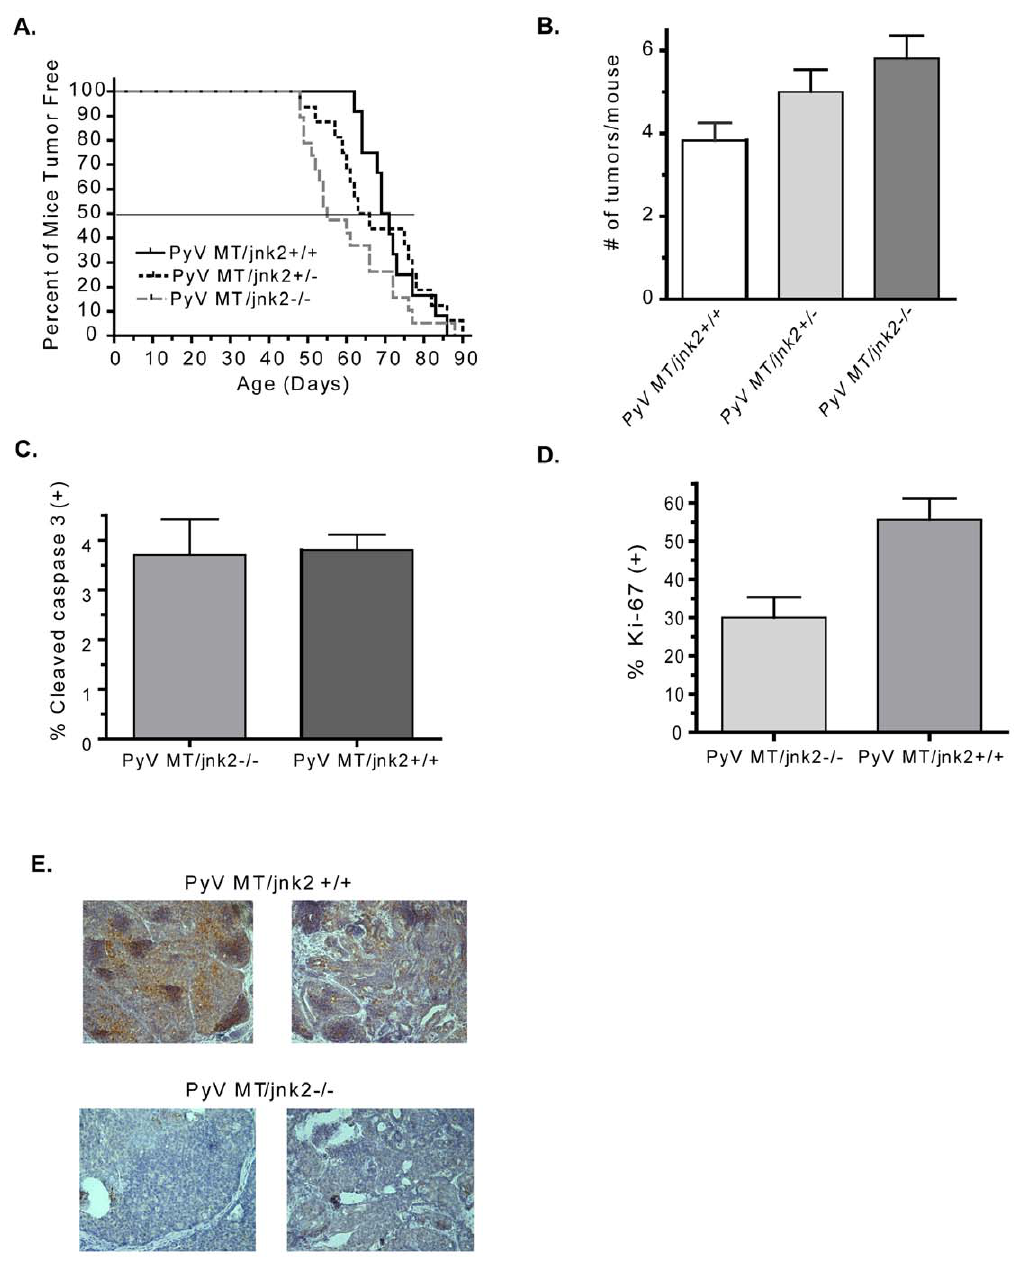
Figure 1. Systemic jnk2 deletion enhances tumor development. PyV MT /jnk2 + / + (n=12), PyV MT/ jnk2 + / 2 (n=16), and PyV MT/ jnk2 2 / 2 (n=19) mice were palpated for mammary tumors thrice weekly. Once palpated, tumor growth was recorded thrice weekly. A ). Kaplan Meier graph showing age